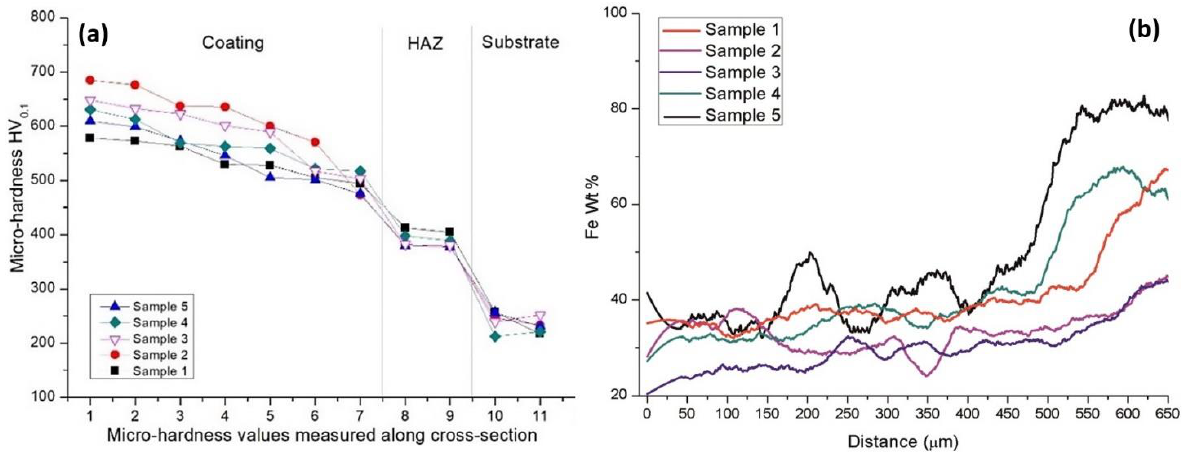
Figure 6. Microhardness measurements from top of the coating to the substrate ( a ) and Fe wt % content from top of the coatings to the substrate ( b ).